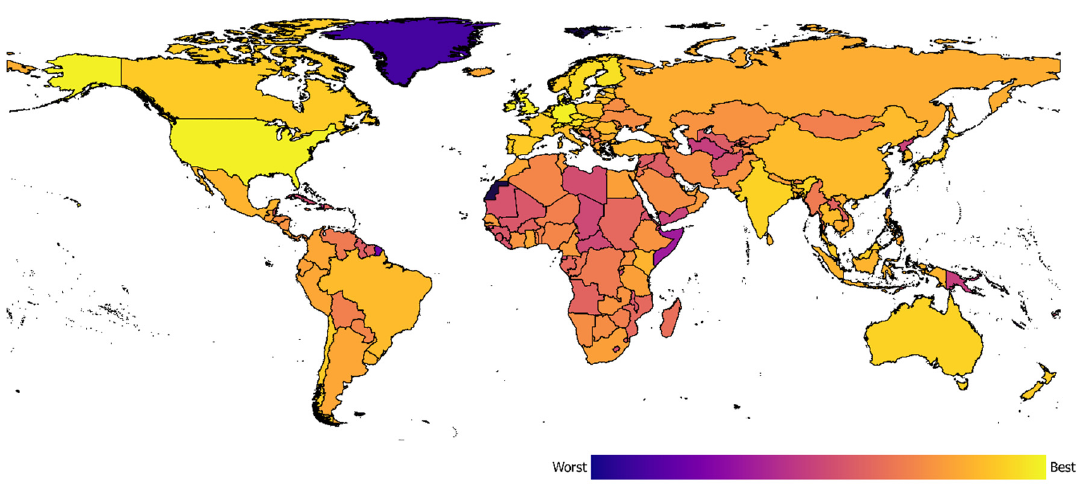
Figure 2. Global view on the energy security index.